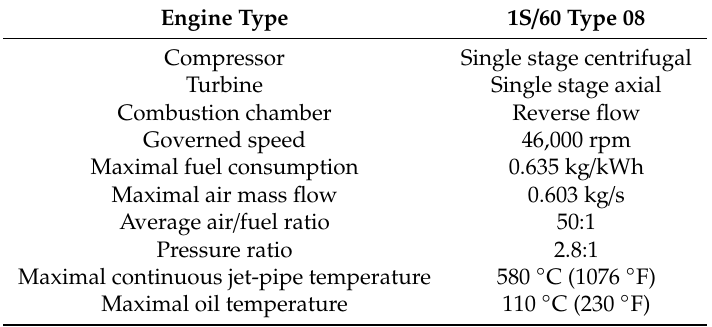
Table 4. Specifications of 1S / 60 Rover gas-turbine engine. Adapted from [32].